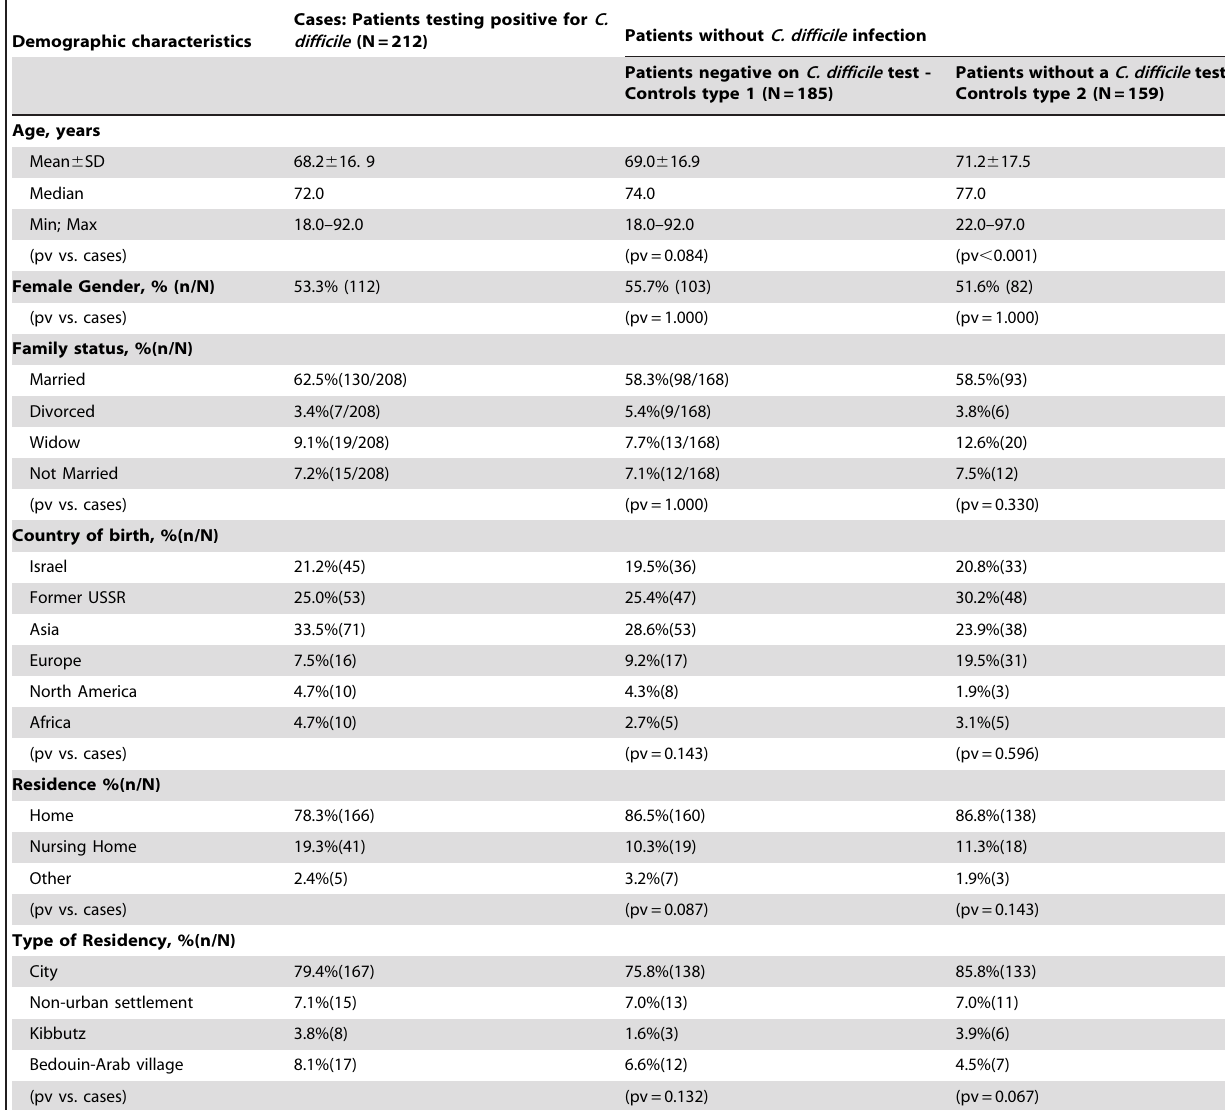
Table 1. Demographic Characteristics of the Study Population.